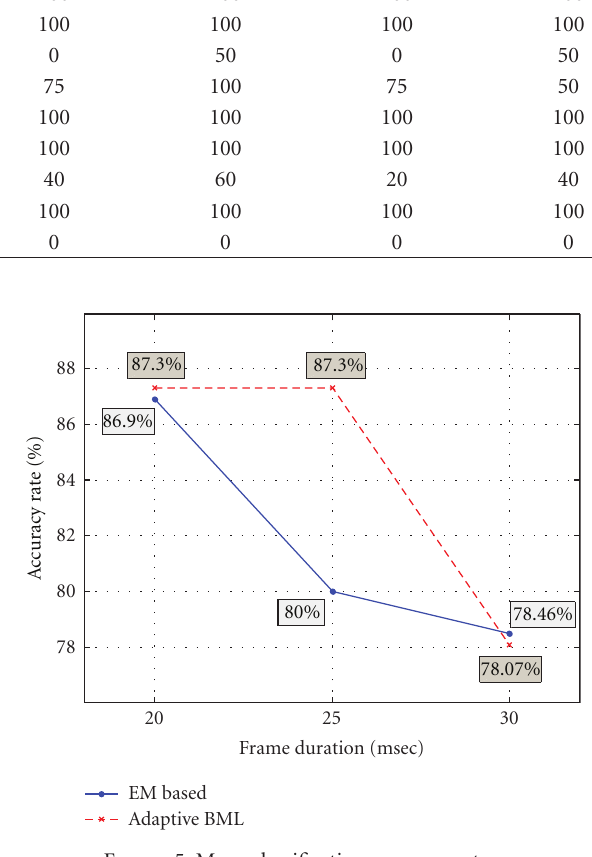
Figure 5: Mean classification accuracy